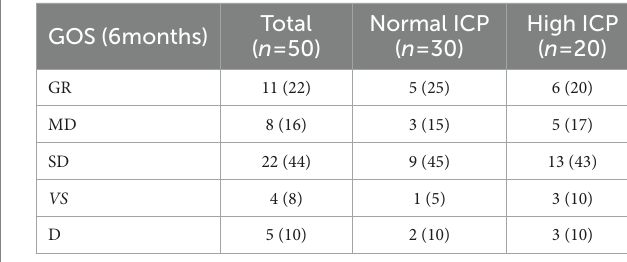
TABLE 5 GOS stratified according to normal versus high ICP